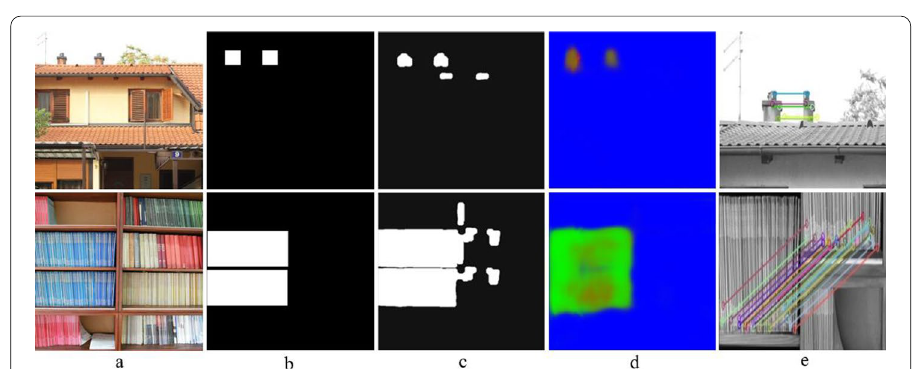
Fig. 15 The results of copy‑move forgery region localization by different methods. a is Forged image, b is Ground truth, c is the results of CKN [29], d is the results of BusterNet [28], and e is